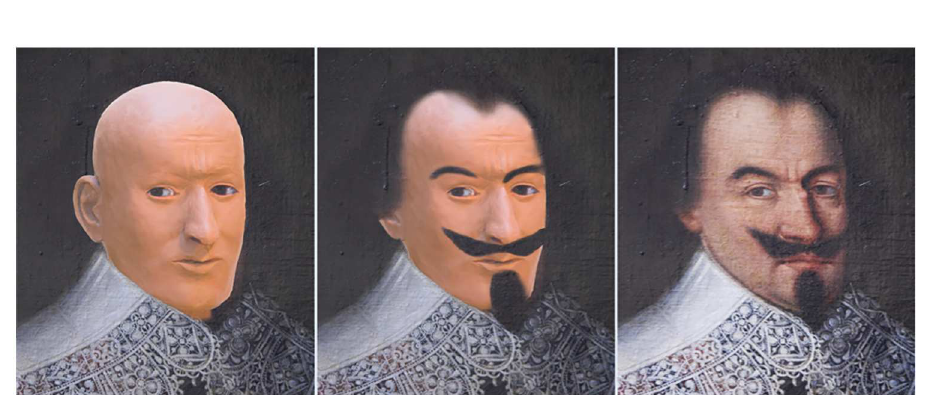
Fig 11. Comparison of the facial reconstruction with the portrait of Jo¨rg Jenatsch. A) Raw facial reconstruction, performed without influenceof the portrait. B) The same hairstylesuperimposed on the facial reconstruction as in the portrait. C) Originalportrait of Jo¨rg Jenatsch (Courtesy of Swiss Embassy in Paris,